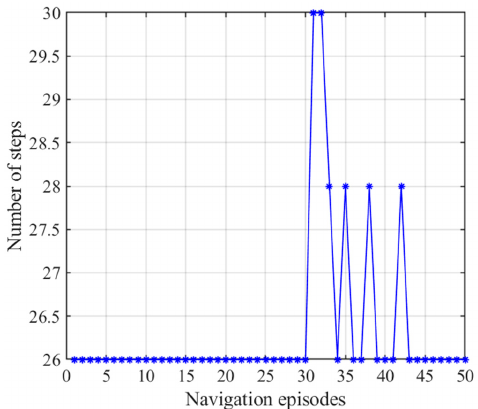
Figure 15. Number of steps with the NLM-HS. Blue asterisks indicate the navigation steps for each navigation episode.